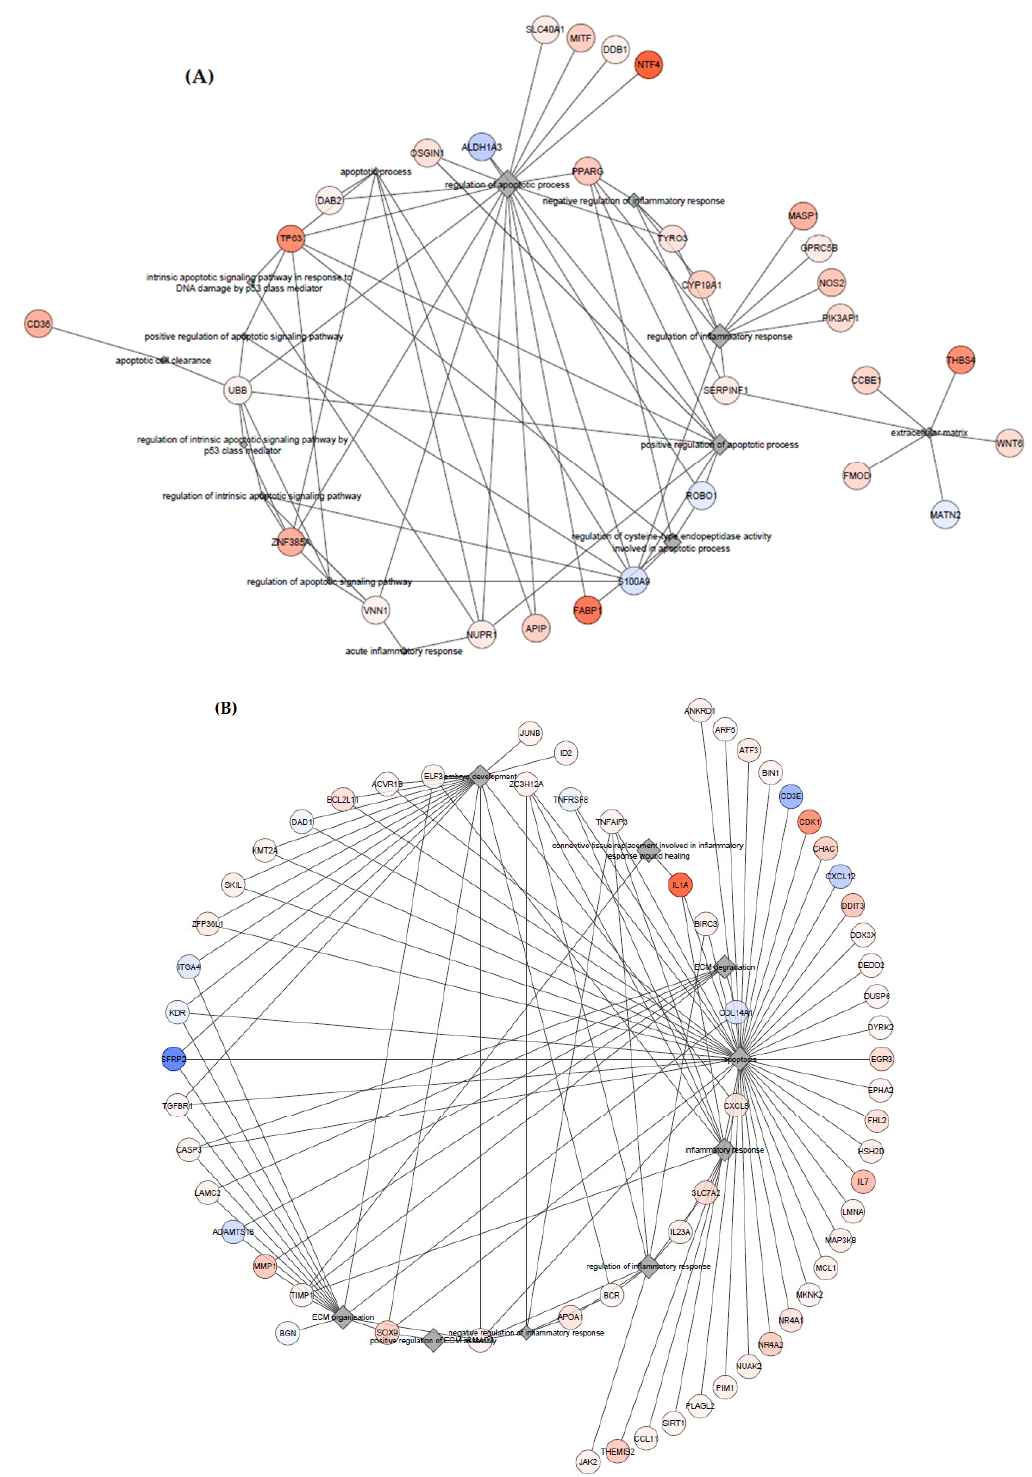
Figure 3. Network of associations between analyzed genes expressed in the endometrium ( A ) and the allantochorion ( B ) and their closest interactions created in Cytoscape v. 3.8.2 with the use of STRING application.